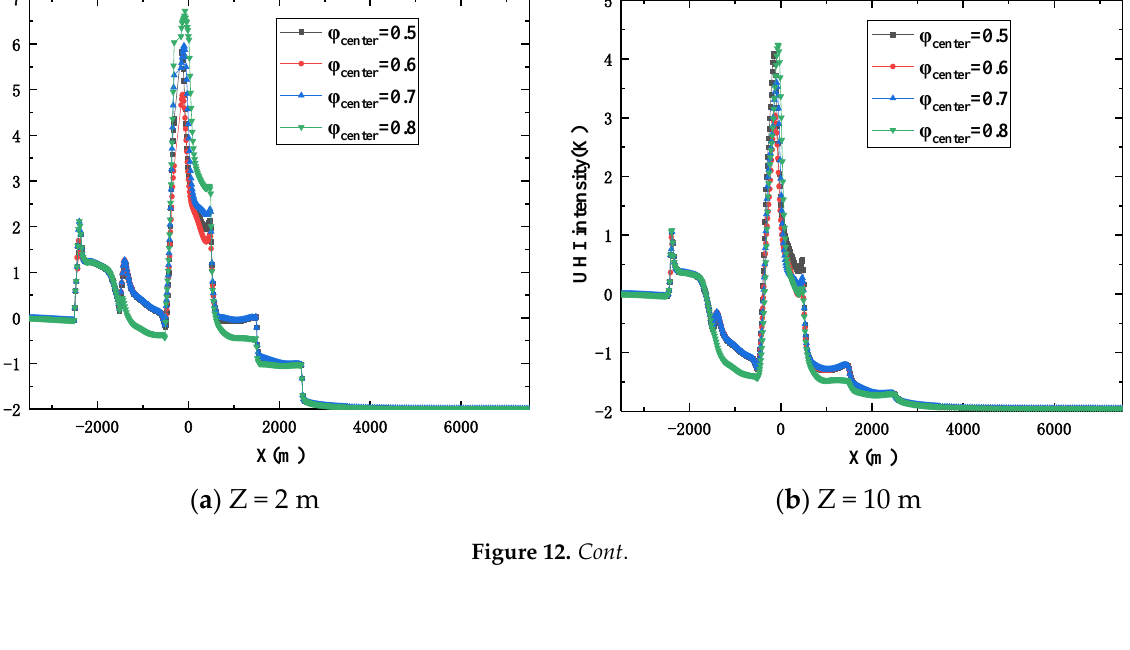
( d ) Z = 80 m Figure 12. The horizontal profiles of the UHI intensities at different porosities in the central business district at the height of ( a ) 2 m, ( b ) 10 m, ( c ) 40 m, and ( d ) 80 m in the plane y = 0. 3.2.3. Influence of Anthropogenic Heat in the Central Business District Studies on the intensity of anthropogenic heat sources in a large number of cities [49,50] have shown that anthropogenic heat intensifies the UHI effect [48,51,52]. Bhuian et al. [53] analyzed the land surface temperature (LST) data from 2000 to 2019 and con- cluded that population, lack of greenery and man-made heat are the main factors affect- ing the urban heat island effect. Yao et al. [54] conducted a combined analysis on satellite data and station data and concluded that human activities are the main driving force leading to the increase of the canopy layer UHI and surface UHI. We assume the intensity of the anthropogenic heat source Q in the central business district to be 40 W/m 2 , 60 W/m 2 , 80 W/m 2 , 100 W/m 2 to investigate the influence of anthropogenic heat on the UHI effect. The porosities inside and outside of the urban area are 0.6 and 0.8, respectively. The intensities of the artificial heat source in the residential area and the transition area are 40 W/m 2 and 60 W/m 2 . As shown in Figure 13, as the intensity of the artificial heat source in the central ur- ban area increases, the UHI intensity in the area increases significantly. The heat source intensity has no effect on the UHI intensity on the downstream transition area and resi- dential area. The first strong UHI effect occurs in front of the city. As the airflow enters the urban area, part of it flows over the city due to the effect of the urban buildings, cre- ating a high wind speed area above the windward edge of the city. The high-speed wind increases heat exchange flux, rapidly dissipating the city’s anthropogenic heat. Therefore,